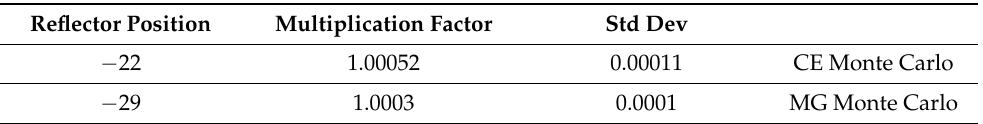
Table 3. Consistency check between the multi-group (MG) Monte Carlo result, as used for this study, and a continuous energy (CE) Monte Carlo result using the same cross-section basis of